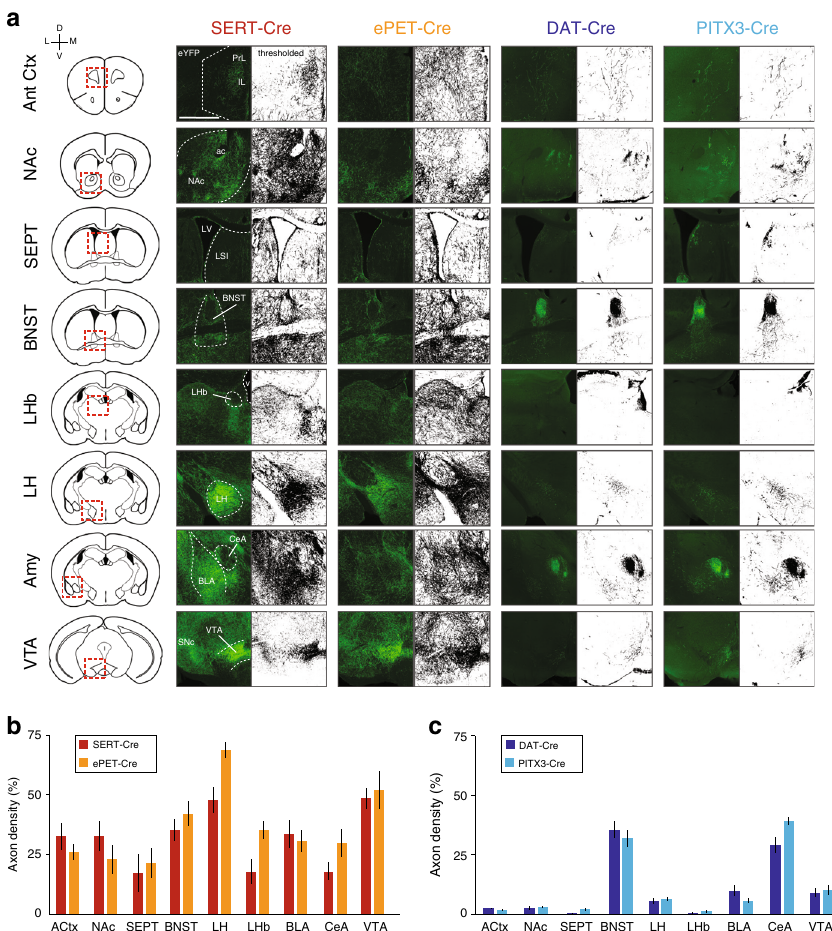
Fig. 3 Projections of DR neurons in different transgenic mouse lines. a Left: Schematic of each anatomical region analyzed. Right: Fluorescence images showing eYFP-labeled terminals in different brain regions from DR neurons targeted using SERT-Cre, ePET-Cre, DAT-Cre, and PITX3-Cre mouse lines adjacent to thresholded and binarized versions of the same images (scale bar 0.5 mm). b Bar graph showing the percentage of each target region that is covered by terminals from DR neurons labeled in SERT-Cre and ePET-Cre mouse lines (two-way ANOVA, main effect of region, F(8,90) = 10.97, p < 0.0001; no main effect of genotype or region by genotype interaction, F ’ s < 3.788, p ’ s > 0.055; n = 6 sections for each region from n = 2 mice in each group). c Same as in b but experiments were performed in DAT-Cre and PITX3-Cre mice (two-way ANOVA, region by genotype interaction F(8,90) = 2.085, p = 0.0453; n = 6 sections for each region from n = 2 mice in each group). Error bars represent SEM. Data provided as a Source Data fi